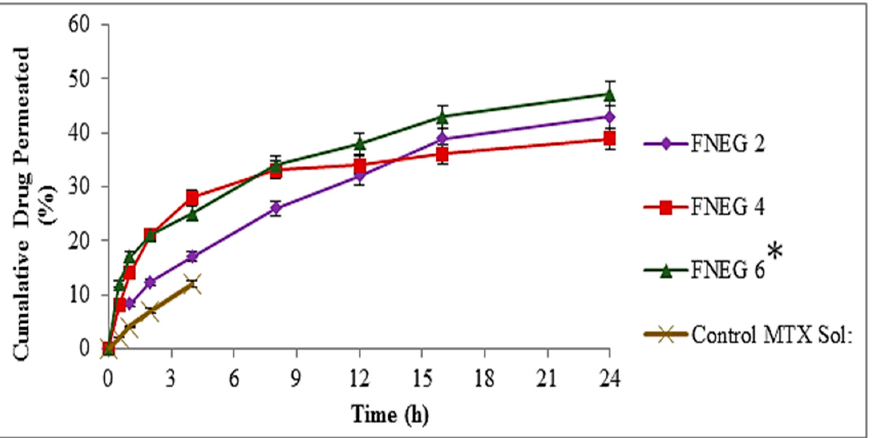
Figure 7. Ex vivo permeation of methotrexate-loaded nanoemulsion gel formulations. Data are expressed as mean ± SD; n = 3. One-way ANOVA followed by post hoc Tukey test ( p < 0.05), FNEG 2, FNEG 4, and FNEG 6 (* p < 0.05).